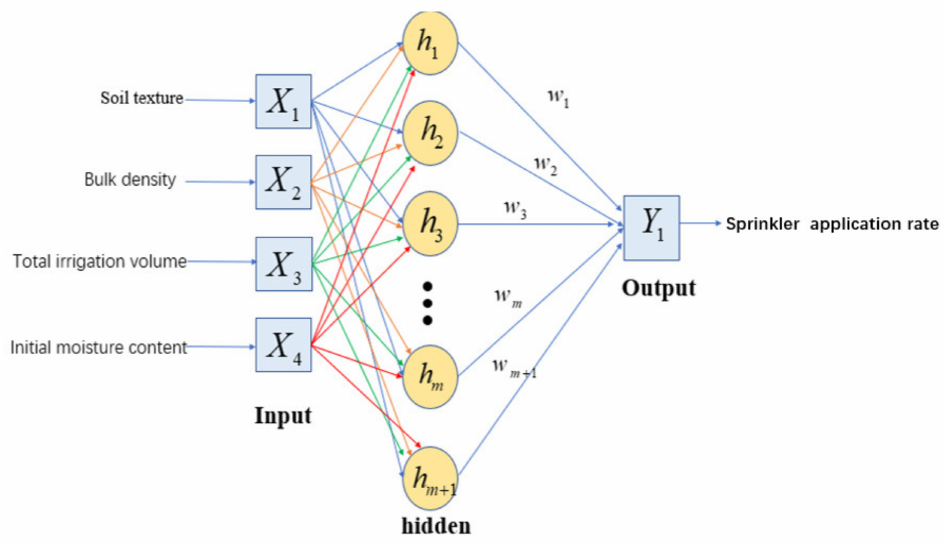
Figure 1. RBF neural network